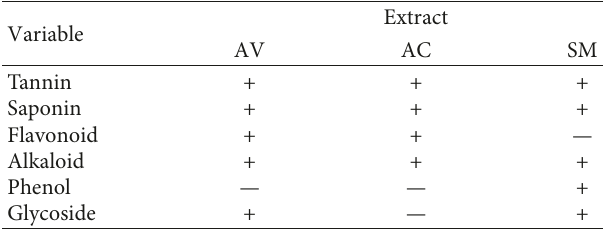
Table 1: Qualitative phytochemical analysis of AV, AC, and SM extracts.